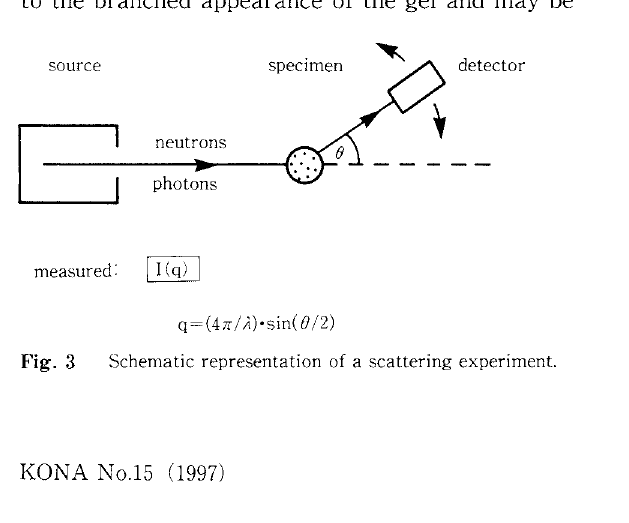
Schematic representation of a scattering experiment. KONA No.15 (1997)